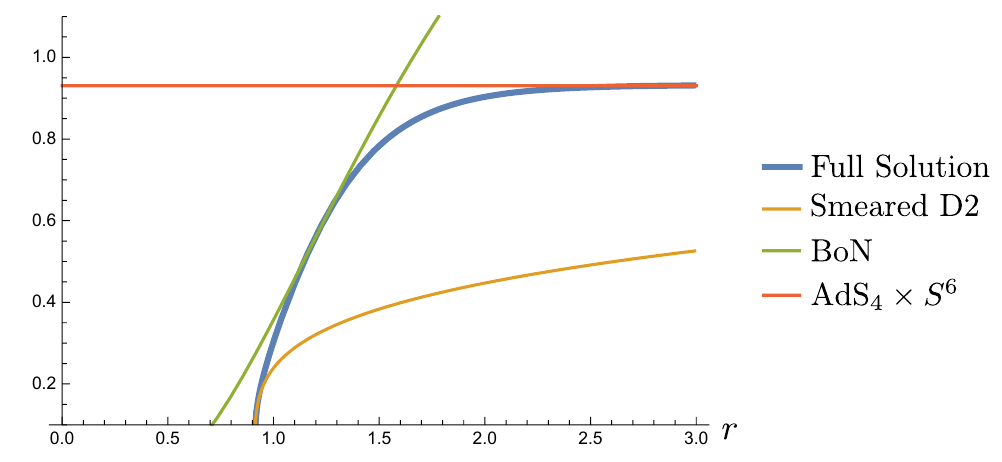
Figure 6: The radial profile of the 10d dilaton e φ